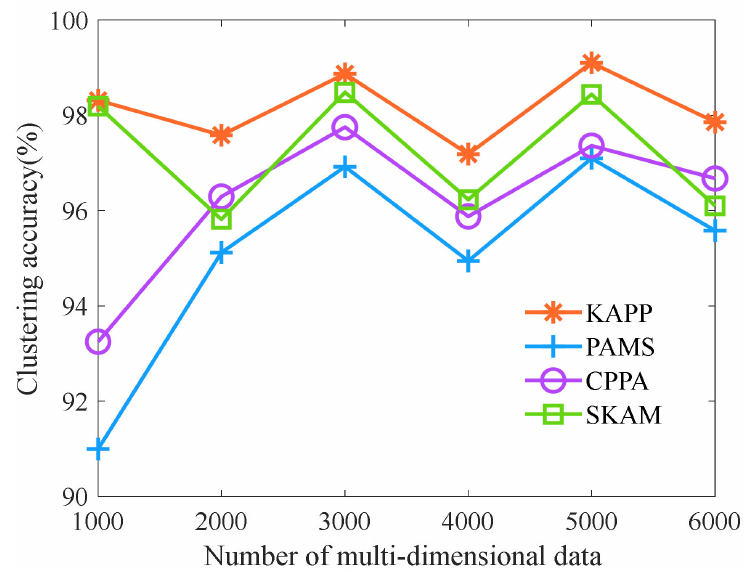
Figure 5. Comparison of clustering accuracy.